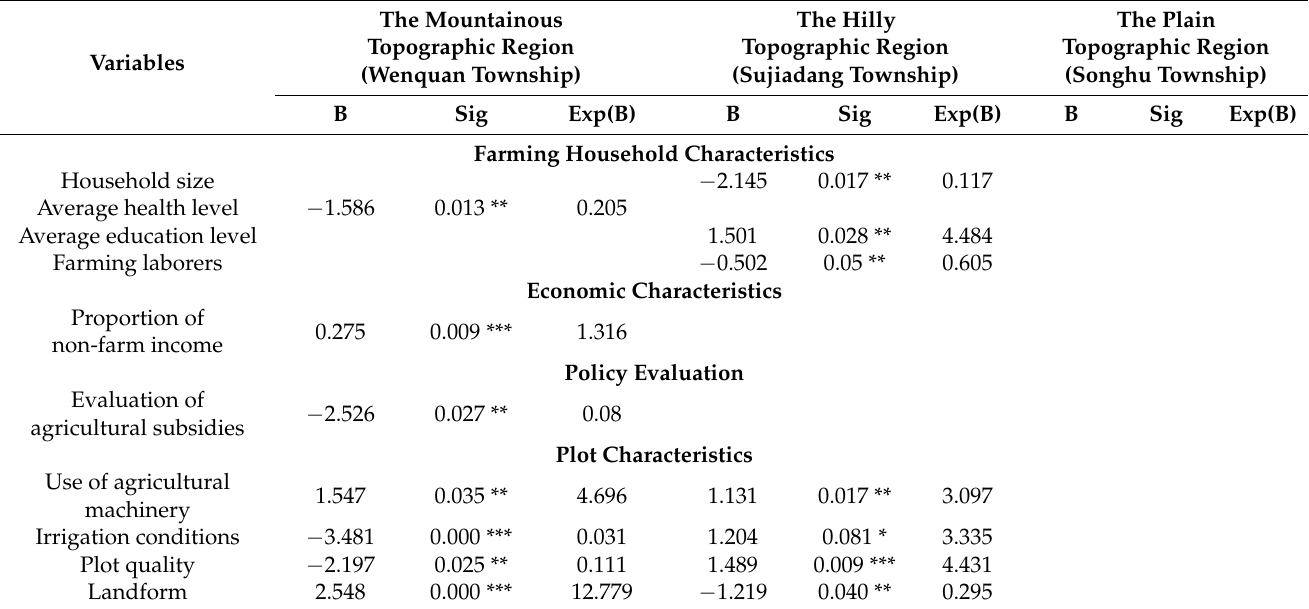
Table 8. Abandonment factors of non-farm households in three topographic